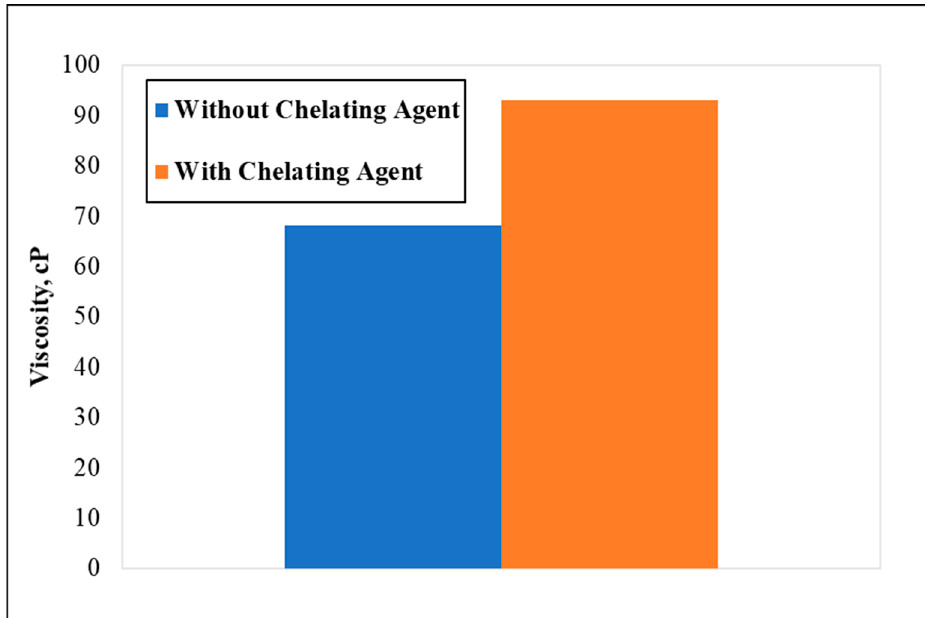
Figure 3. The effect of GLDA addition (10 wt%) on the viscosity (polymer concentration= 40 pptg, shear rate= 171 s − 1 , temperature= 77 °F, water salinity= 70 k).